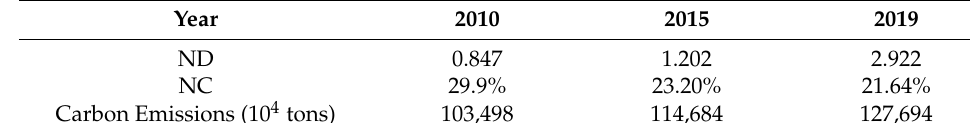
Table 2. Change in ND, NC and carbon emissions in southwest China.